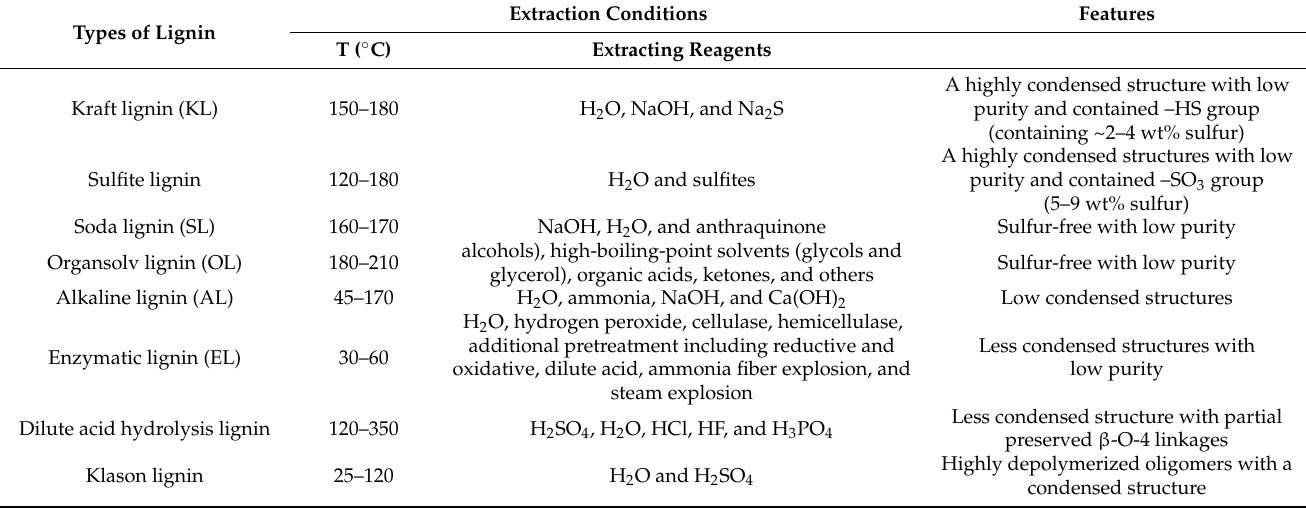
Table 1. Several types of lignin and their extraction